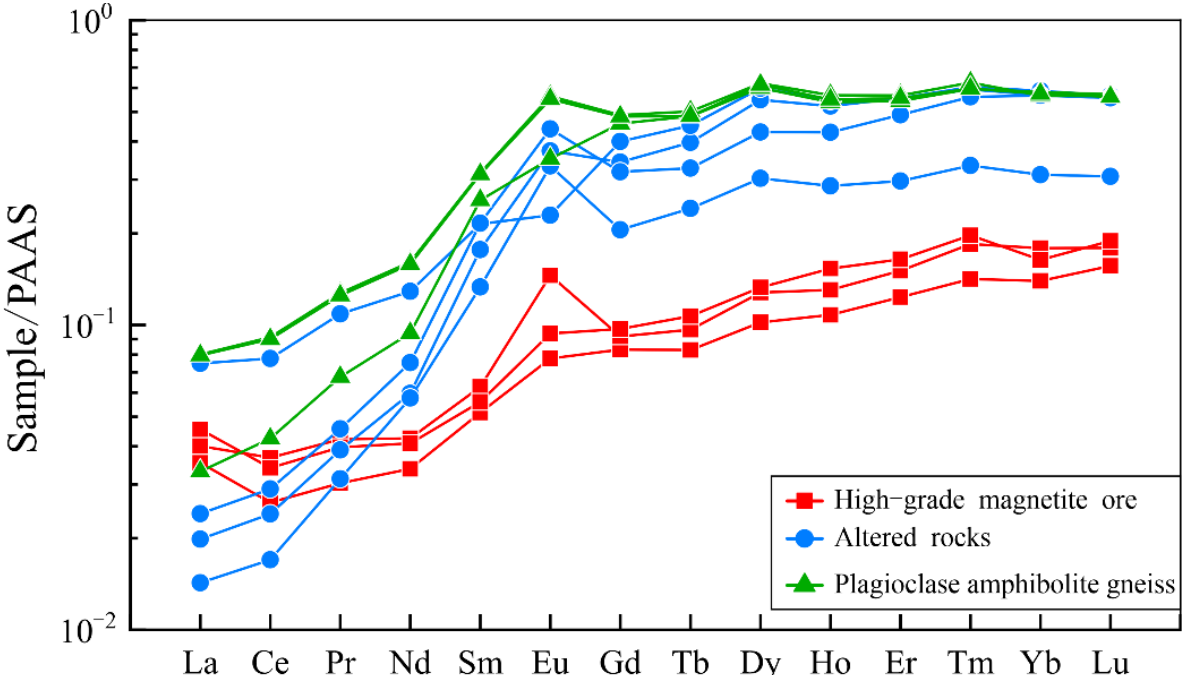
Figure 7. PAAS-normalized rare earth element patterns in Gongchangling No. 2 Mining Area.